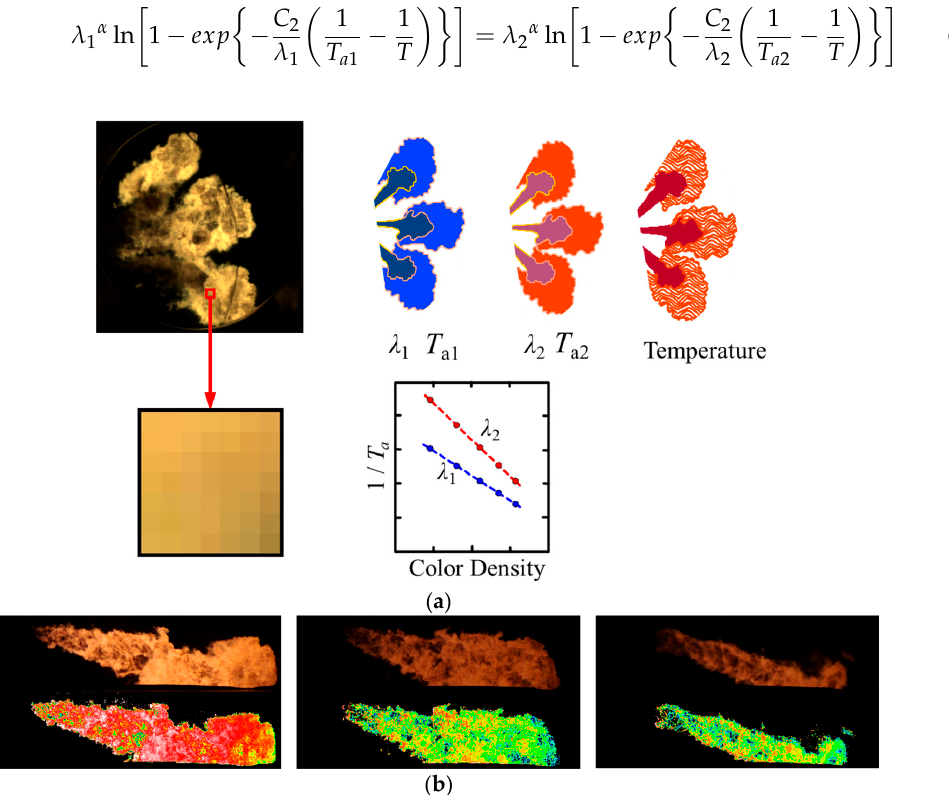
Figure 8. Two-color method definition and the application process. ( a ) the explanation of the picture analysis ( b ) an example of the results with the source